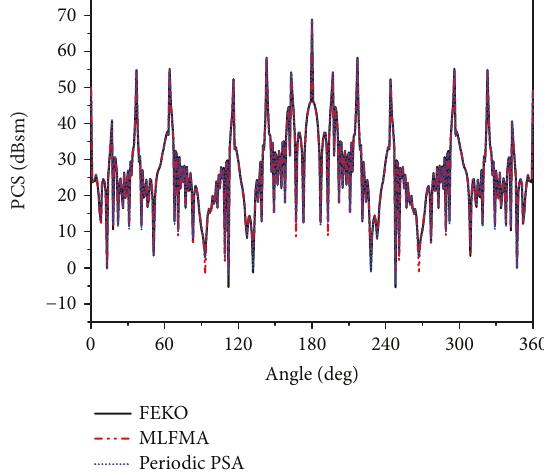
Figure 3: Radar cross sections (V-V polarization) of the 32 × 32 sphere array with 0.5m gap computed by FEKO, MLFMA, and periodic PSA. The incident plane wave angles satisfy θ = 0 ° and φ = 0 ° . The scattering angles work with θ varies from 0 ° to 360 ° and φ = 0 °